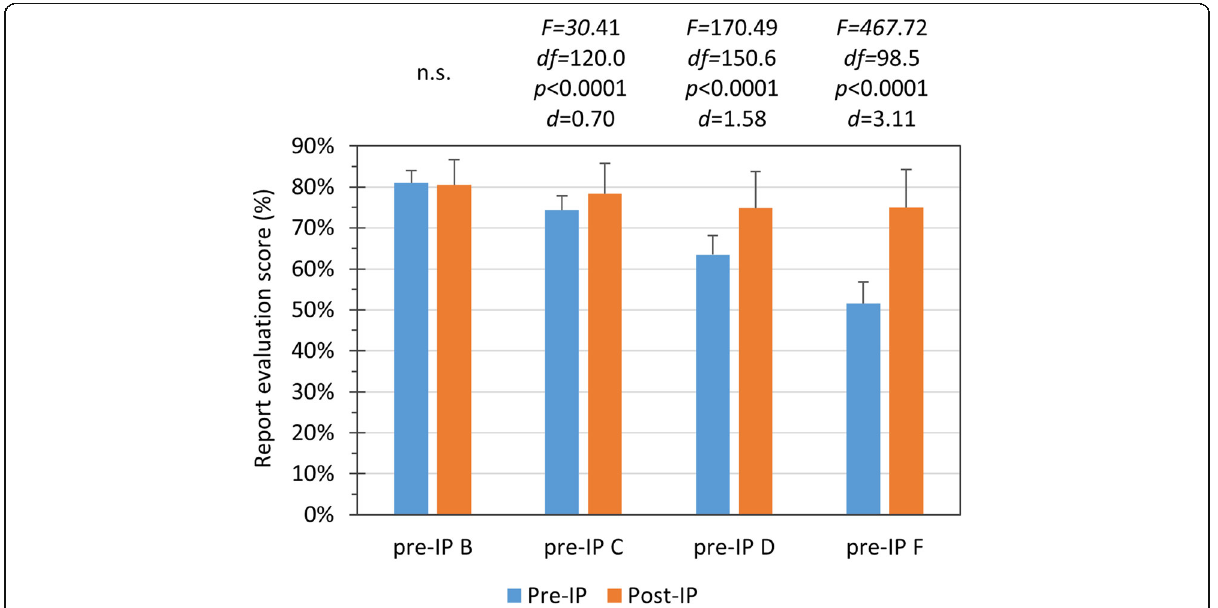
Fig. 6 Improvements in report evaluation score for students at different levels of pre-inquiry project performance. Comparison of the pre-inquiry project (pre-IP) and post-inquiry project (post-IP) scores for evaluation of an inquiry report using a rubric, for each of the pre-IP performance groups (made B, C, D, or F, respectively, in pre-IP evaluation of inquiry report; n = 123, 121, 126, 97). The F -Ratio, df , and p value for mixed model ANOVA and the effect size (Cohen ’ s d ) are shown above each group